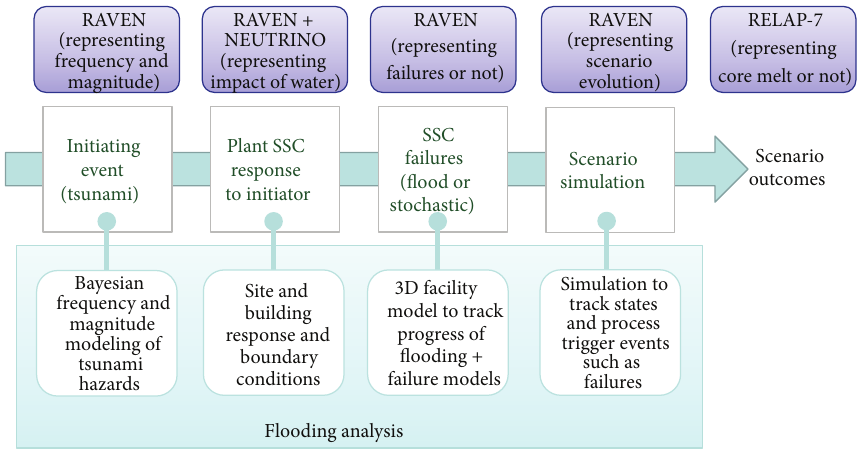
Figure 9: Overview of the RISMC approach to simulate initiating event and plant response using the RISMC toolkit.